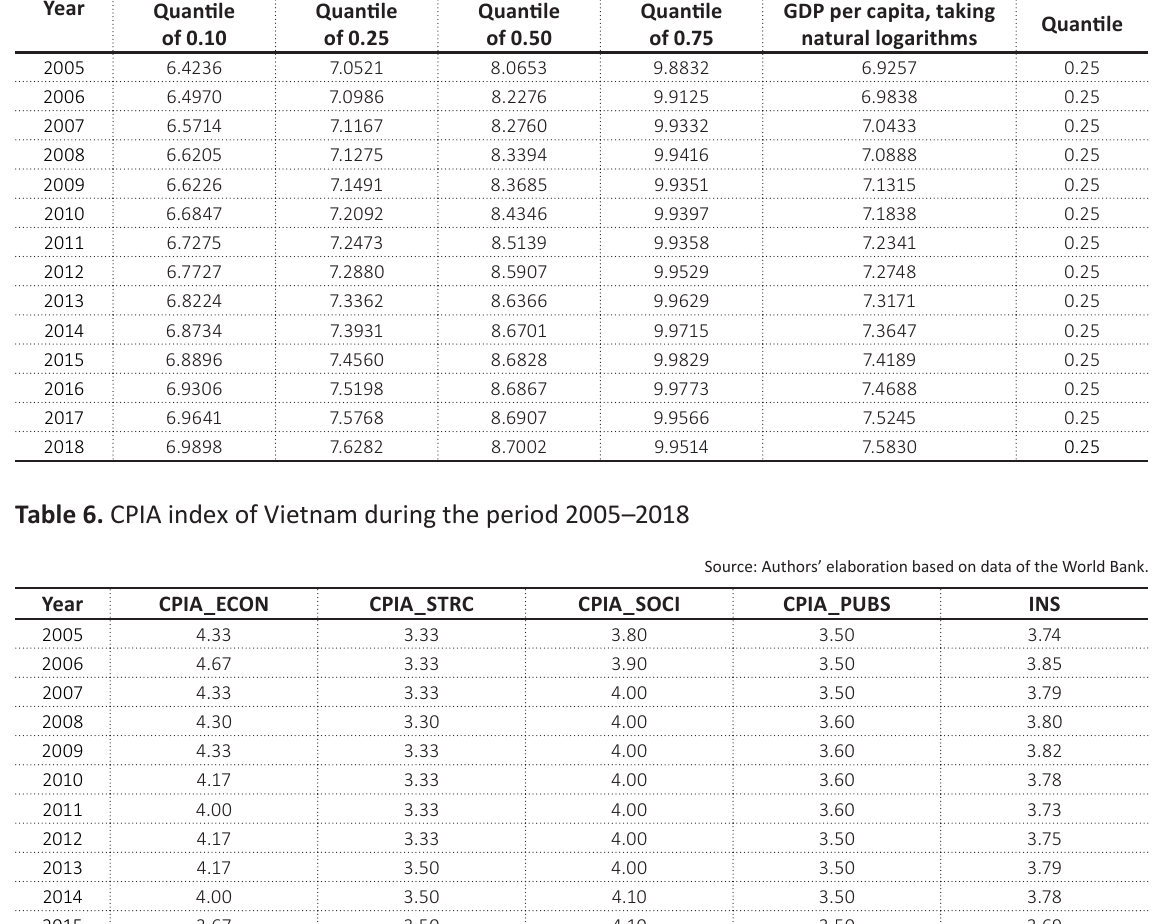
Source: Authors’ elaboration.